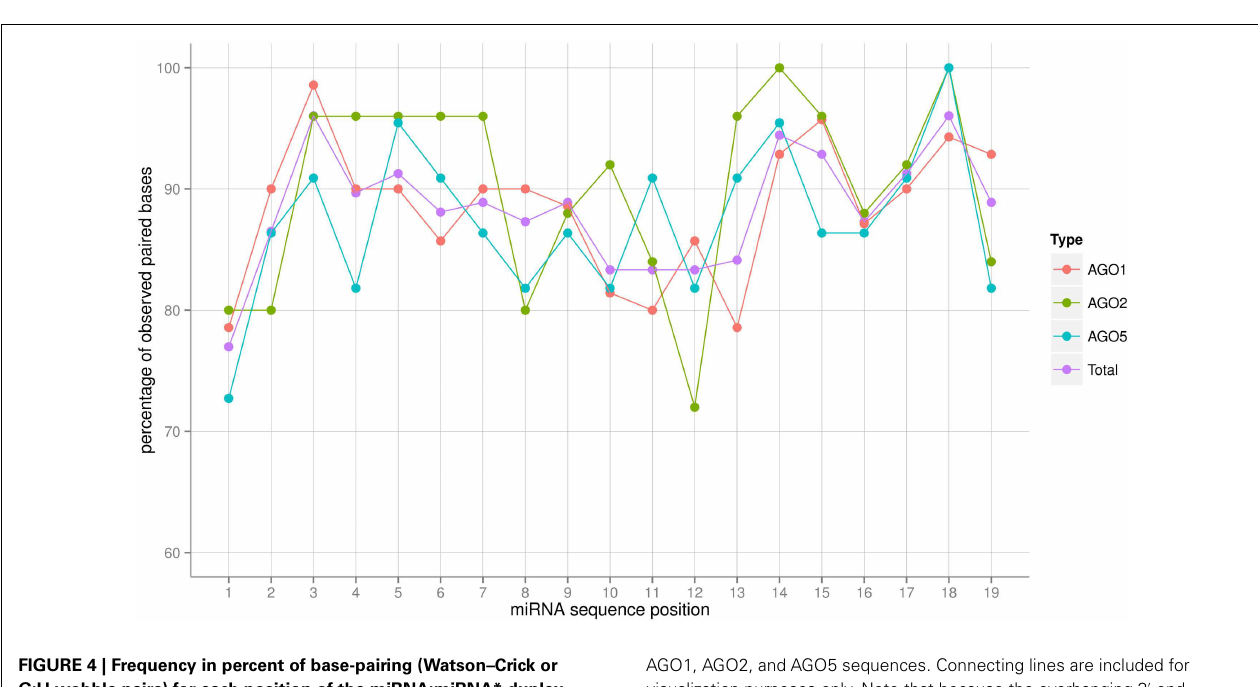
FIGURE 4 | Frequency in percent of base-pairing (Watson–Crick or G:U wobble pairs) for each position of the miRNA:miRNA* duplex as predicted by RNAhybrid. The frequency was obtained by dividing the number of sequences in which base-pairing occurred at a given position by the total number of miRNA sequences associated with a particular AGO. “Total” refers to the average of a combined set of all